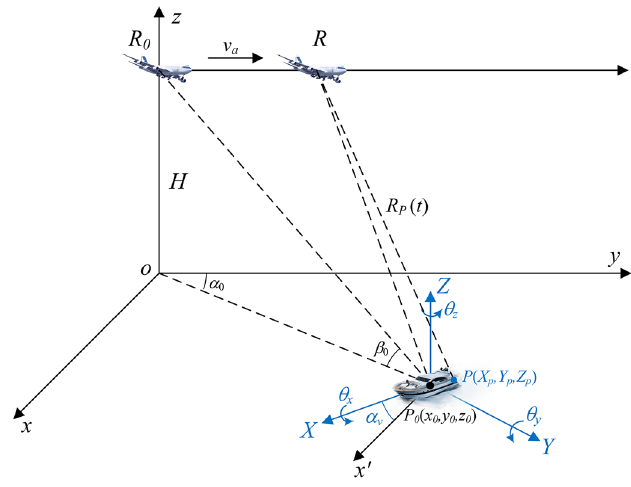
Figure 6. The geometry of a ship with angular